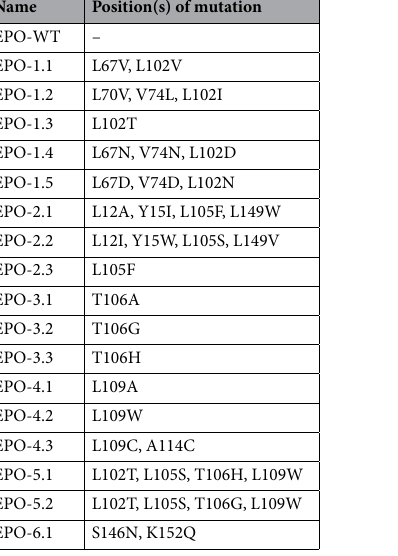
Table 1. List of EPO